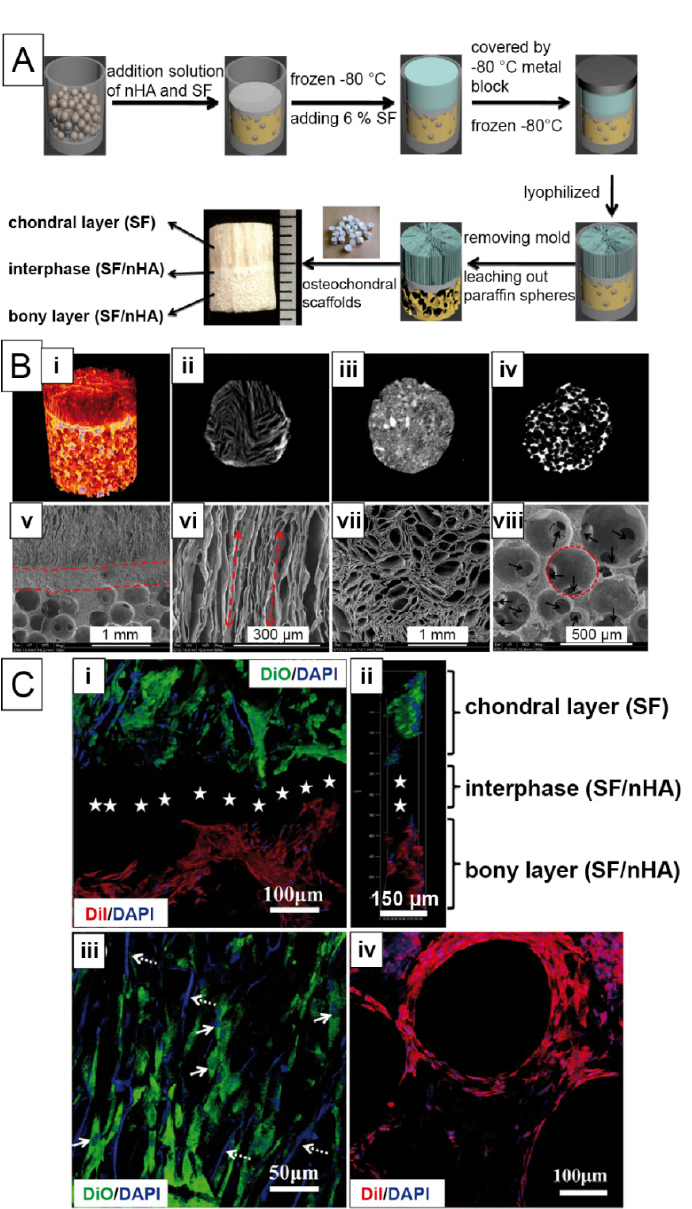
Figure 9. ( A ) Illustration of a trilayer (e.g., chondral, interphase and bony layer) scaffold preparation process using Bombyx mori silk. ( B ) Micro-CT (µCT) and scanning electron microscopy (SEM) images of the individual layers in the scaffold: ( i ) µCT of the full construct, ( ii ) µCT of the chondral layer (top), ( iii ) interphase, ( iv ) bony layer (bottom), and ( v ) SEM of a longitudinal section of the full construct (red lines indicate interphases), ( vi ) of a longitudinal section of the chondral layer (red arrows indicate orientation), ( vii ) of cross-sections of the chondral layer, ( viii ) of cross-sections of the bony layer (red circle indicate a macropore and black arrows connections between pores). ( C ) Confocal microscopy images of trilayer scaffolds of rabbit adipose-derived stroma cells after 3 d in ( i ) longitudinal section and ( ii ) profile view with magnifications of ( iii ) the chondral layer and ( iv ) the bony layer. Blue staining indicates cell nuclei (DAPI), green and red staining cell membranes (DiO, DiI) confirming the interphase as an isolation layer. White solid arrows indicate stained cell nuclei, white dashed arrows indicate unspecific staining, white stars indicate the cell-free intermediate layer. SF = silk fibroin, nHA = hydroxyapatite nanoparticles. Reprinted and adopted with permission from ref. [144]. Copyright 2014 American Chemical Society.